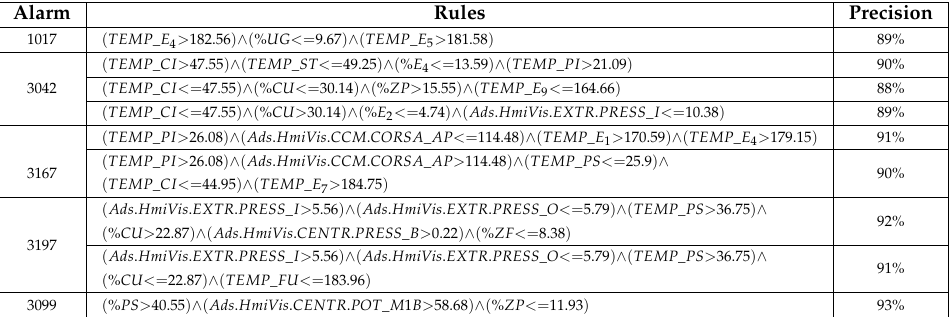
Table 8. Decision Tree (DT) based rule learner (RUL = 120 s).